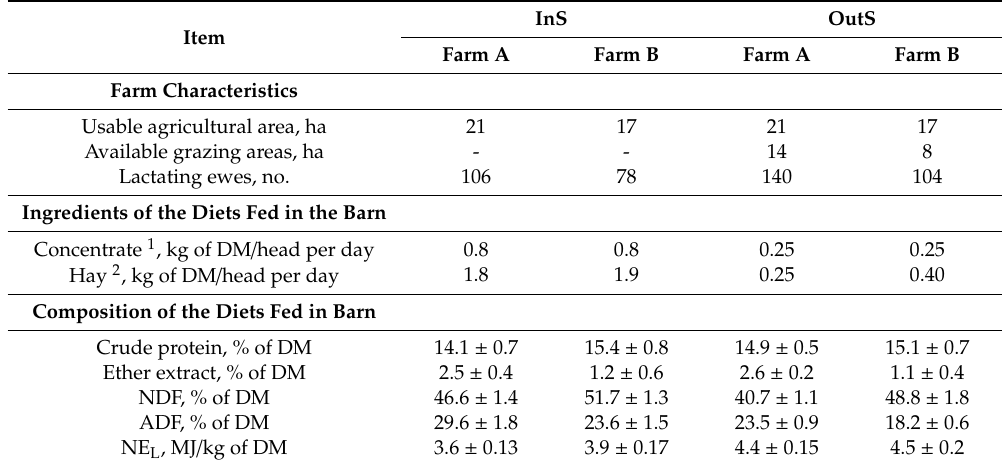
Table 1. Farm characteristics and ingredients and composition of the diets fed in the barn under the two management systems (raw means ±